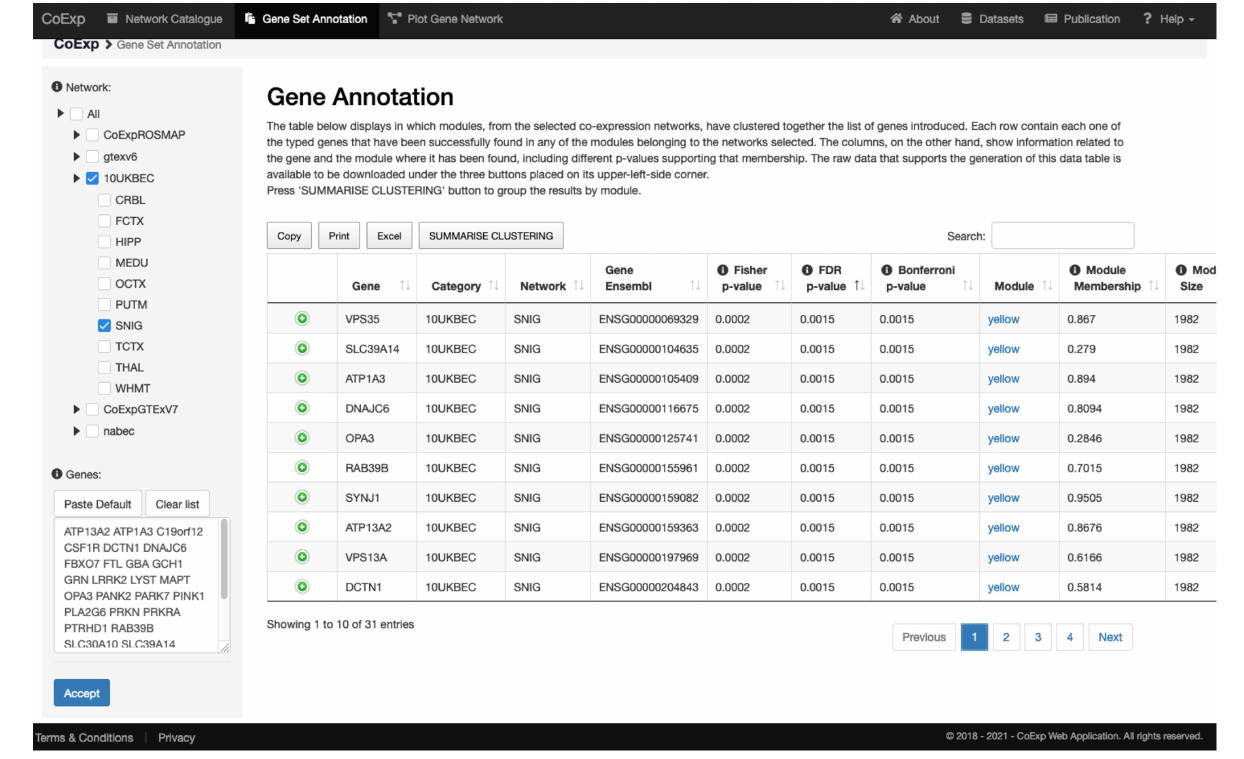
FIGURE 5 | Use of the gene set annotation tab. This screen capture shows the results of using the Gene Set Annotation tab with 32 genes associated with juvenile Parkinson’s disease (visible within the text pane in the bottom left) and used as the default example when arriving at CoExp for the 1st time, together with default family and network values too (namely the SNIG network from UKBEC as used in Figures 3 , 4 ). The analysis yields the results on the right table. Each row corresponds to information about one gene out of the 32 genes used for this example. For example, in the 1st row we see that VPS35 has a module membership of 0.867 within the SNIG yellow module. Furthermore, VPS35 significantly clusters within the yellow module with many other juvenile Parkinson’s disease genes. In fact, 10 out of the 32 genes cluster together within the yellow module. The module has 1,982 genes and the Fisher’s exact test for the overlap yields a significant p-value (FDR 5% P < 0.0072). If we click on the “yellow” link then we can inspect this module as we did for the purple module described in Figure 3 , 4 . In the case of the latter, we would see that that the module is enriched for multiple dopaminergic gene markers ( P < 2.78 × 10 − 6 ) and that the most significantly enriched GO terms include transport ( P < 1.25 × 10 − 19 ) and the establishment of localization ( P < 3.16 × 10 − 18 ) amongst others. All annotations can be downloaded in the form of an Excel file for further inspection. For a visual demonstration of this same example, the interested user may access a video-tutorial available at the Help section of the CoExp web under the “Gene Set Annotation”